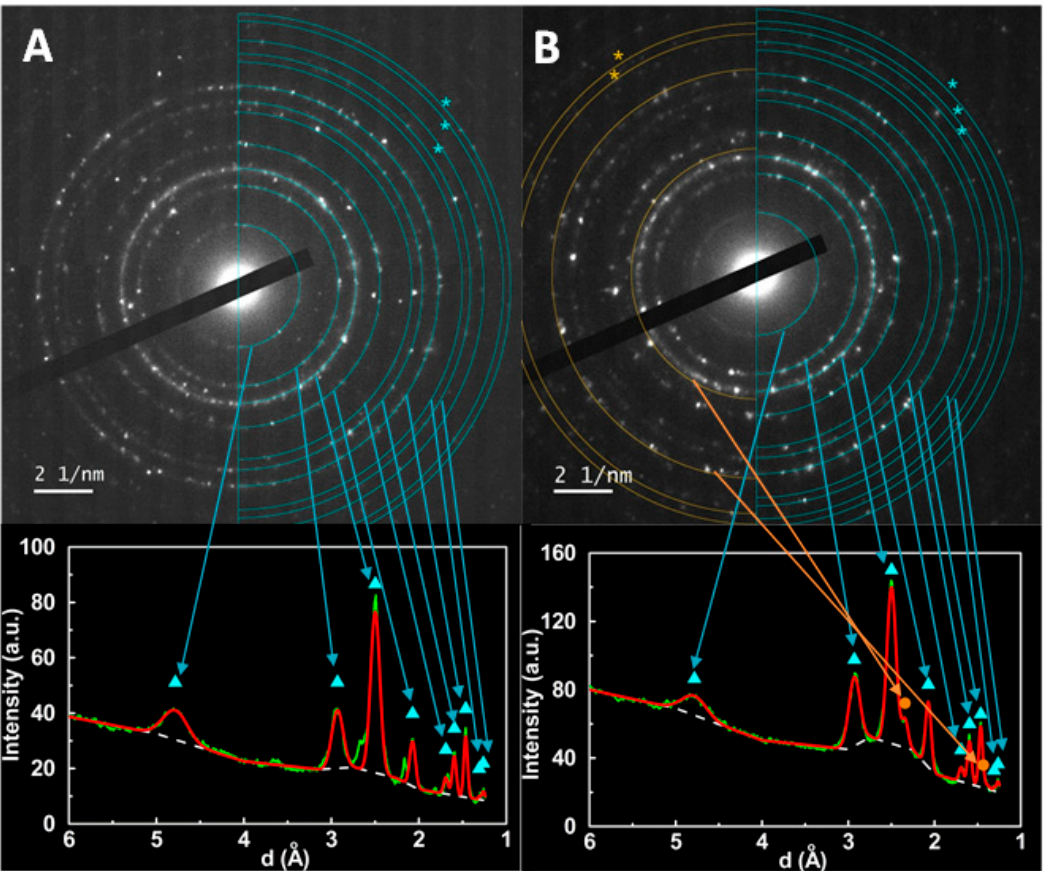
Figure 4. TEM SAED images of the synthesized zinc/calcium ferrite nanoparticles, without (A) and with silver (B) . Below each image, a radial profile together with a fit is represented, considering the diffraction lines of zinc/calcium ferrite (marked by cyan triangles) and silver (marked by orange circles). Rings marked by asterisks pass by additional diffraction spots, but did not define a complete circle, not being possible to use in the radial profile.